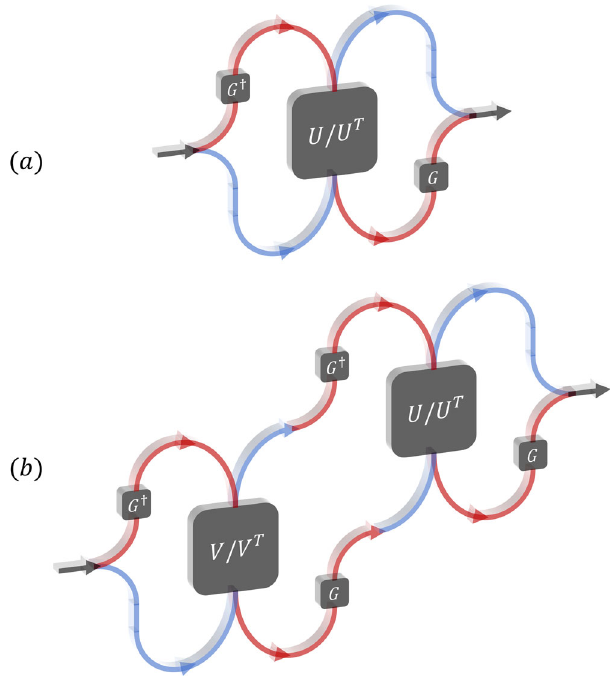
Fig. 4 Photonic realisation of the superposition of a process and its input- output inverse. Using a beamsplitter, a single photon is coherently routed along two paths, one (in blue) traversing an unknown waveplate from top to bottom, and the other (in red) traversing it from bottom to top. Along one path, the photon polarisation experiences a unitary gate U , while on the other path it experiences the transpose gate U T , up to a change of basis G that is undone by placing suitable polarisation rotations before and after the waveplate. a The two paths are fi nally recombined in order to allow for an interferometric measurement on the control qubit. b By concatenating two setups with the above structure, one can probe two unitary gates U and V in a superposition of time directions, implementing the winning strategy in Eq.